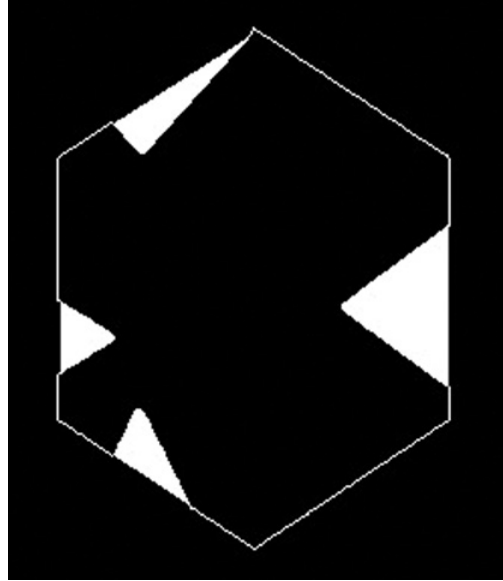
Figure 8: Sunken Boundary Filling Result for Figure